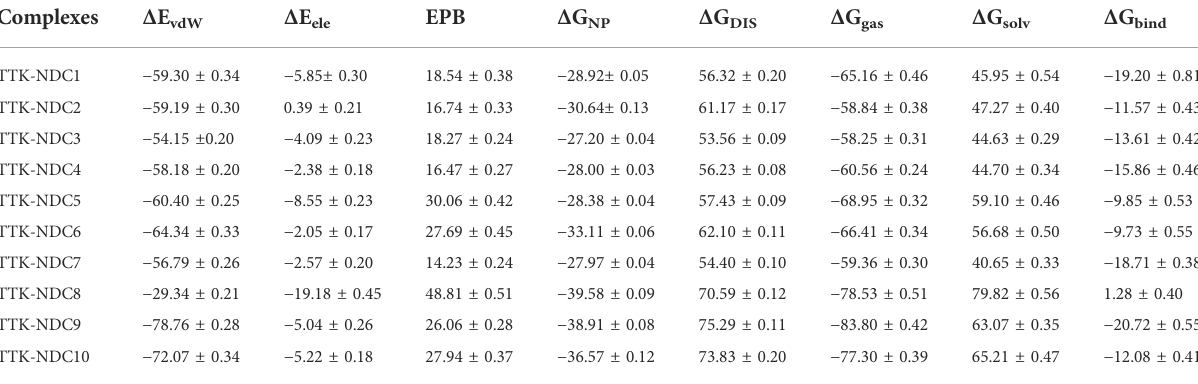
TABLE 3 Components of the binding free energies of TTK and designed compounds complexes. Complexes